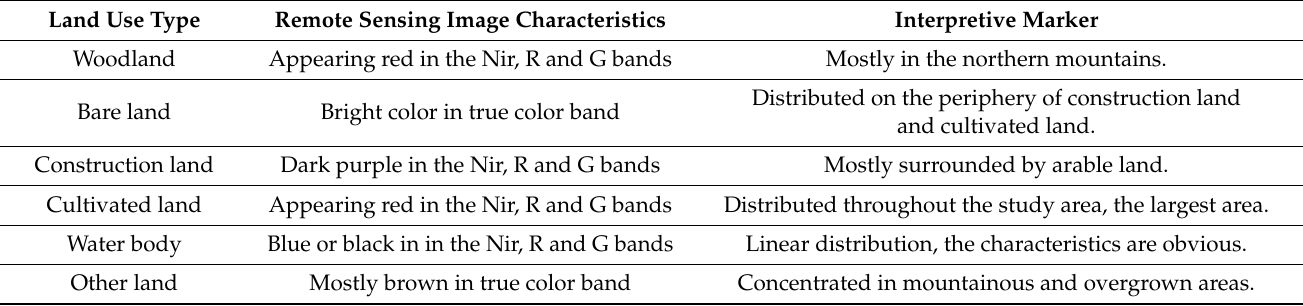
Table 1. Remote sensing interpretation signatures of land use types in Jiaozuo